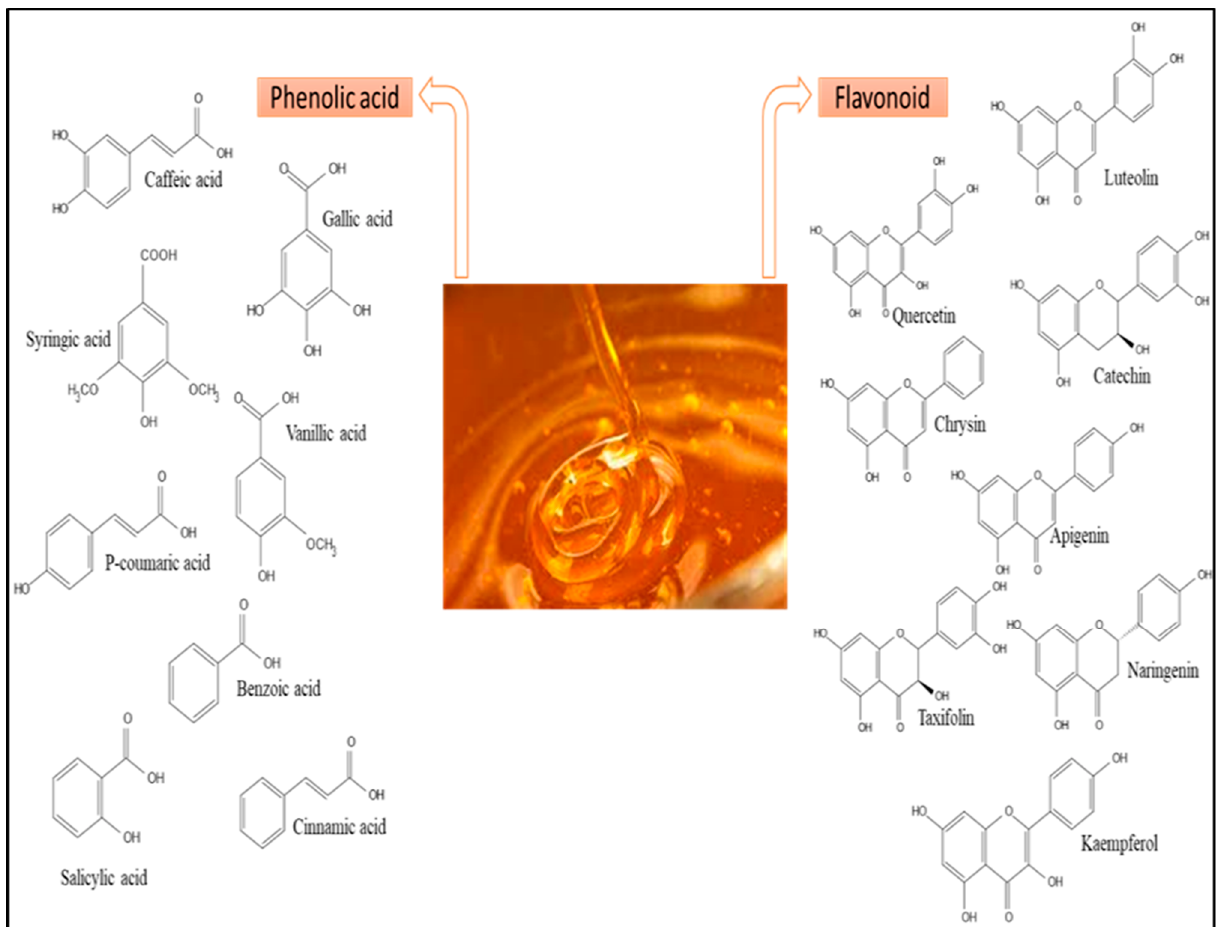
Figure 2. Most common phenolic compounds identified in honey. Adapted from Cianciosi et al. (2018) [67]. Table 2. The most common phenolic compounds (flavonoids and phenolic acids) identified in MH, TH, KH, and SH [18,41,68–70].